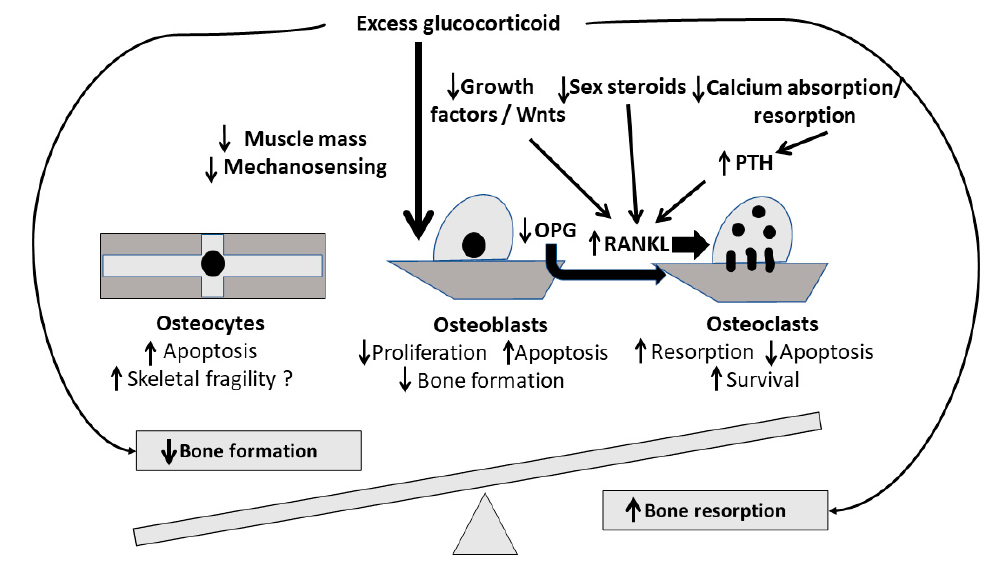
Figure 1. An illustrative overview of GC action on bone remodeling. Regarding BTMs and their correlation with the changes of bone mass (BM), there is evidence that can be used to monitor bone metabolism in patients with autoimmune dis- eases under GC treatment [24–26]. Moreover, BTMs may serve as prognostic markers for GC induced bone loss assessment [24] as well as for monitoring the response to osteopo- rosis treatment [27]. The aims of this pilot study were to prospectively investigate the effect of HDIST on bone metabolism in newly diagnosed MS patients (NDMSP) and evaluate the relationship between BM changes, BTMs, and inflammatory cytokines. 2. Materials and Methods 2.1. Subjects Twenty-five NDMSP (10 women) with previous minor symptoms, mainly sensory disturbances, were referred to the Neurology Department of the 401 Military Hospital of Athens and prospectively enrolled during a period of 5 years; all patients met the 2017 McDonald Criteria for MS diagnosis [28]. They received 1000 mg of Methylprednisolone intravenously every day for 5 consecutive days, followed by 60 mg of oral prednisolone per day, the dose being tapered over 21 days. Main inclusion criteria also included: age 18–45 years, fully ambulatory patients (EDSS ≤ 1), and women with regular menstruation periods. Exclusion criteria were defined as: medical history of any chronic disease, previ- ous GC treatment in any dosage regimen, treatment with agents affecting bone metabo- lism, and EDSS ≥ 2 during follow-up. Seven patients were excluded due to mobility im- pairment, with an increase in EDSS score (EDSS ≥ 2) in the first 3 months of follow-up, and a further eight were lost to follow up. In the remaining 10 patients (6 men), demo- graphic and clinical data, including disease modifying treatments (DMTs), were evalu- ated prior to GC administration and then on days 2, 4, 6, and 90, and months 6, 12, 18, and 24. Clinical activity of the disease was assessed by EDSS score and brain/spine magnetic resonance imaging (MRI) at baseline, 90 days post diagnosis, and then every 6 months until the end of the study. During the 24-month follow-up, DMT was initiated to all pa- tients (interferon beta n = 4; fingolimod n = 2; natalizumab n = 1; dimethyl fumarate n = 1; teriflunomide n = 1; cyclophosphamide n = 1). None of the patients received additional